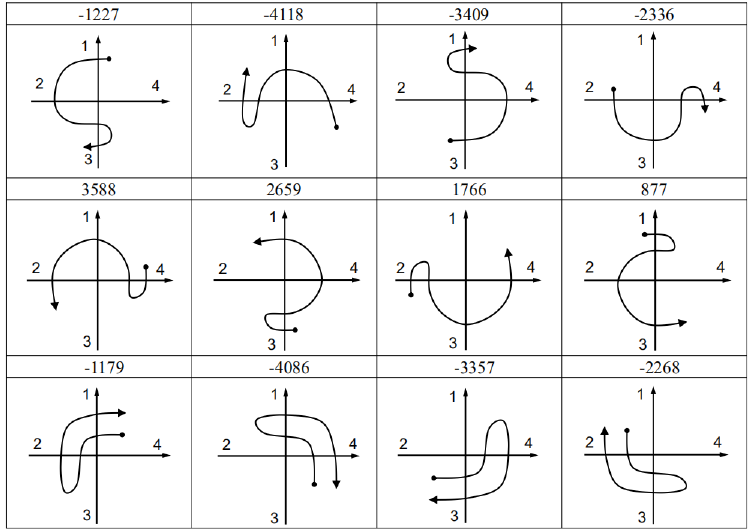
Figure A3. Code templates and sketch maps of left gesture.